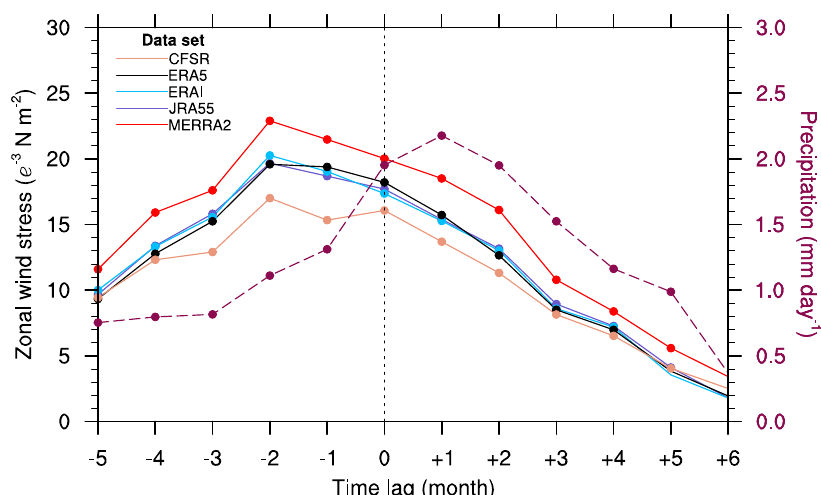
Fig. 4 Paci fi c El Niño-type precipitation and wind stress variability. Right axis, dashed curve: precipitation anomalies averaged over the Paci fi c Niño3 and Niño4 regions (5°N – 5°S, 160°E – 90°W) in all calendar months regressed on the normalized Niño3 SST index (that is, average in the region 5°N – 5°S, 90° – 150°W) fi xed in December (lag = 0). Left axis: zonal-wind stress averaged over the Niño4 region (5°N – 5°S, 160°E – 150°W) in all months regressed on the normalized Niño3 SST index fi xed in December (lag = 0). Circular ticks denote statistical signi fi cance at the 95% con fi dence